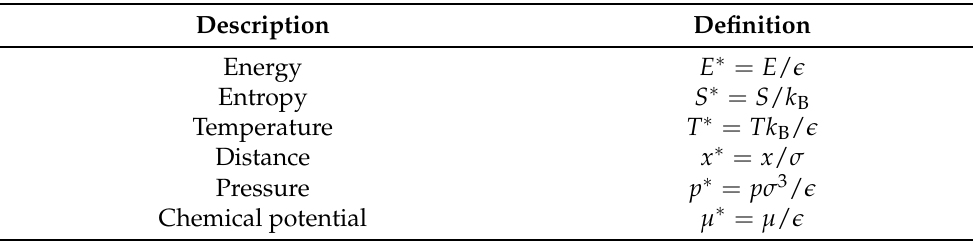
Table 1. The reduced units are denoted with an asterisk in superscript, for example T ∗ . The variables are reduced using the molecular diameter σ , potential well depth (cid:101) , fluid particle mass m and Boltzmann constant k B